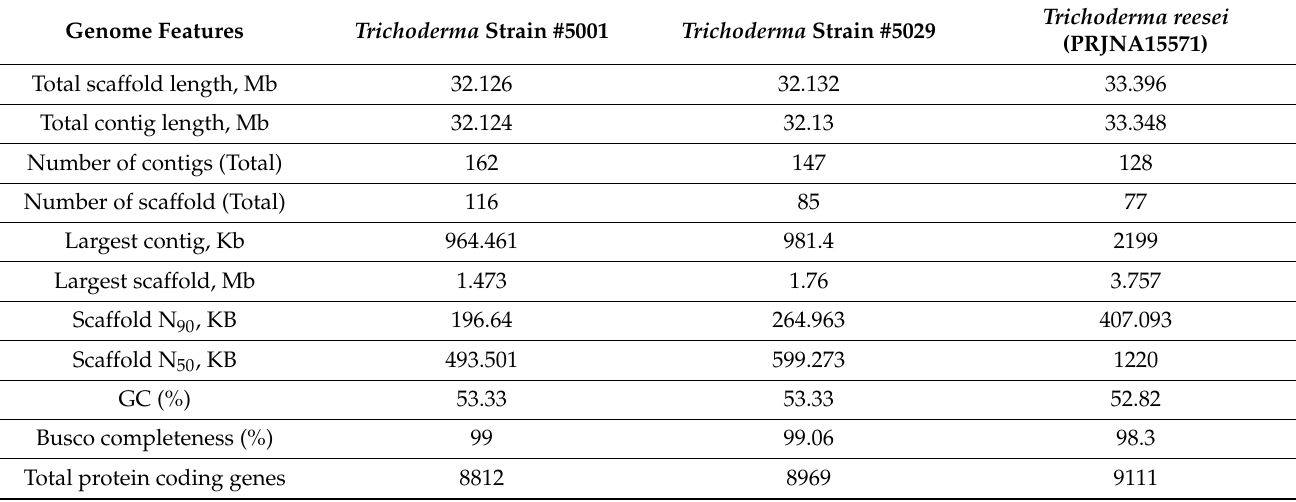
Table 1. Comparison of genome assembly statistics of Trichoderma strain #5001 and #5029 with the reference strain Trichoderma reesei